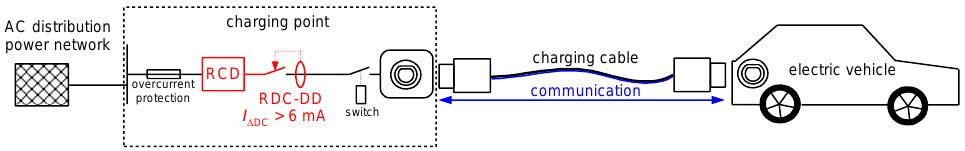
Figure 3. An example supply system for charging of electric vehicles. RCD — residual current device, RDC-DD — residual direct current detecting device.